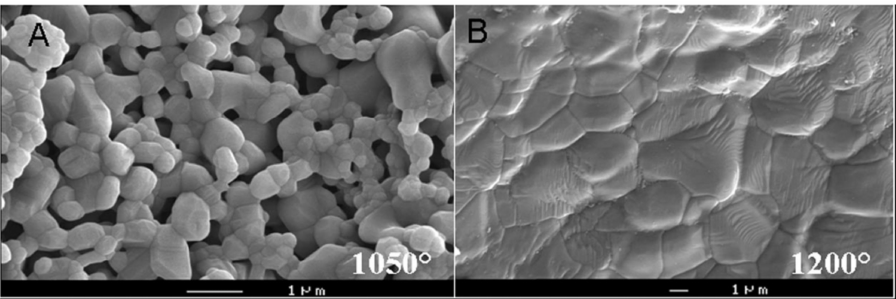
Figure 10. SEM pictures of HA bioceramics sintered at ( A ) 1050 ◦ C and ( B ) 1200 ◦ C. Note the presence of microporosity in A and not in B . Reprinted from Ref. [544] with